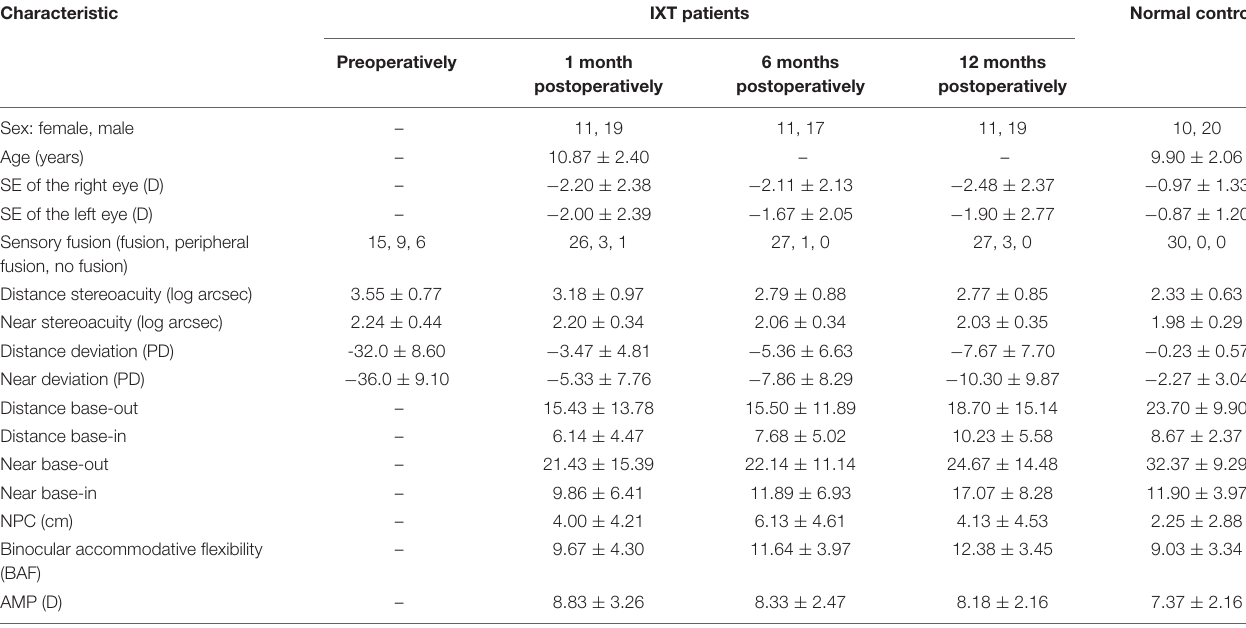
TABLE 1 | Demographics and clinical characteristics of the patients with IXT and normal controls. Characteristic IXT patients Normal controls